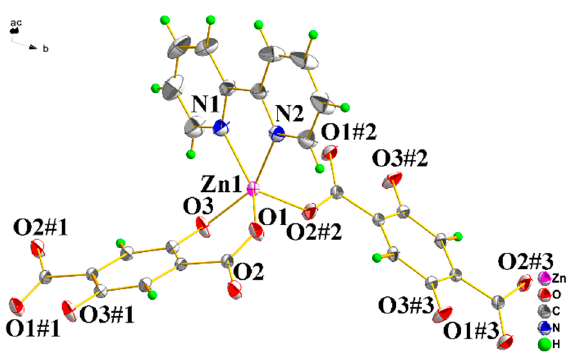
Figure 1. The coordination environment of the complex (Symmetry codes: #1 = − x, − y, 1 − z; #2 = x, 0.5 − y, 0.5 + z; #3 = − x, 0.5 + y, 1.5 − z.).